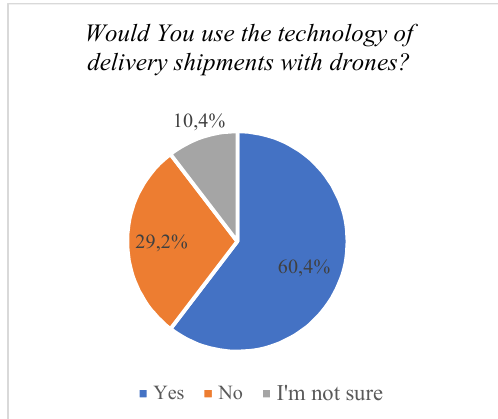
Figure 8. Question Results: Would You use the technology of delivery shipments with autonomous vehicles?